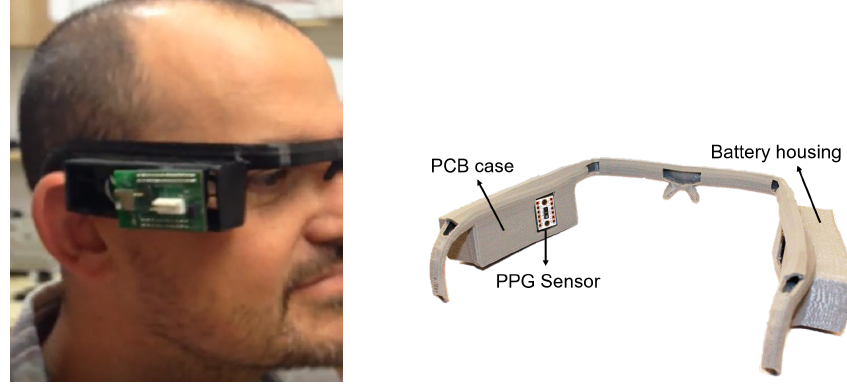
Figure 8. Proof-of-concept frame for prototype integration.